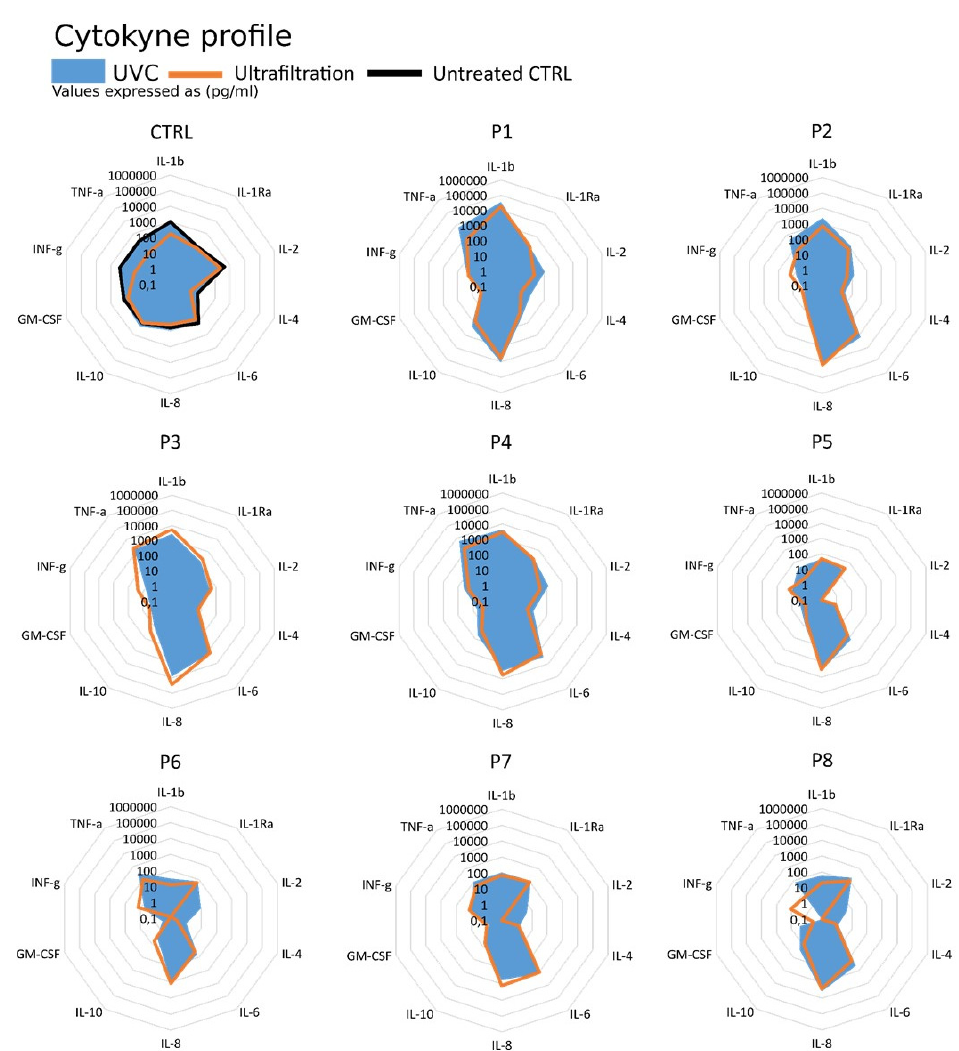
Figure 4. Cytokine/chemokine profiles of the patient BAL samples. The standard calibration mix has been used as reference control (CTRL) for the treatments.